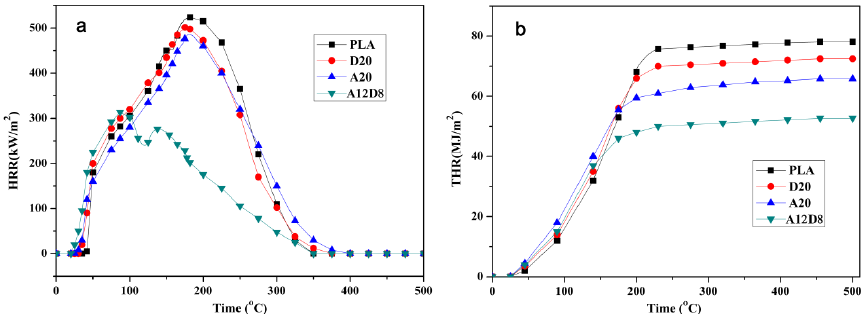
Figure 3. PLA, D20, A20 and A12D8 curves: ( a ) HRR and ( b ) THR.